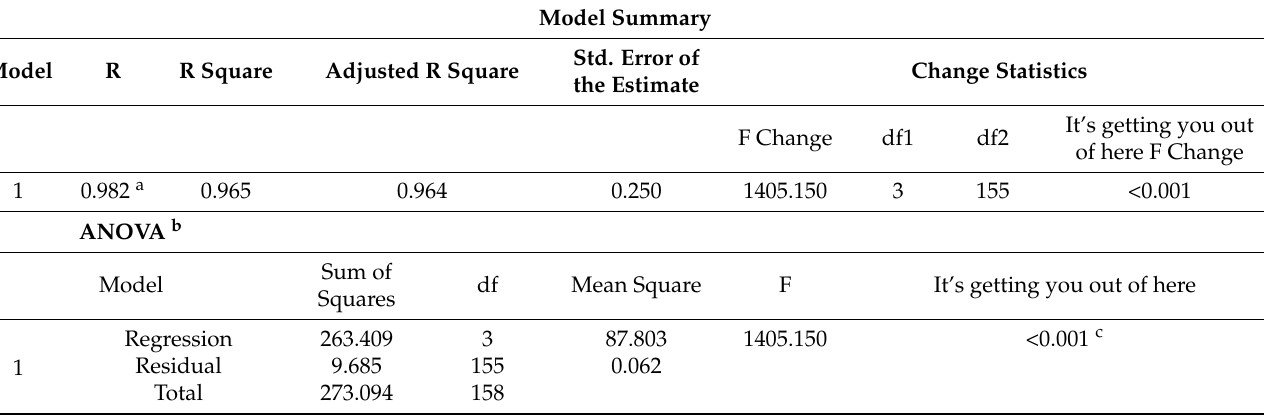
Table 13. Multiple regression analysis between independent variables and the dependent variable on the exercise firm for 159 respondents.